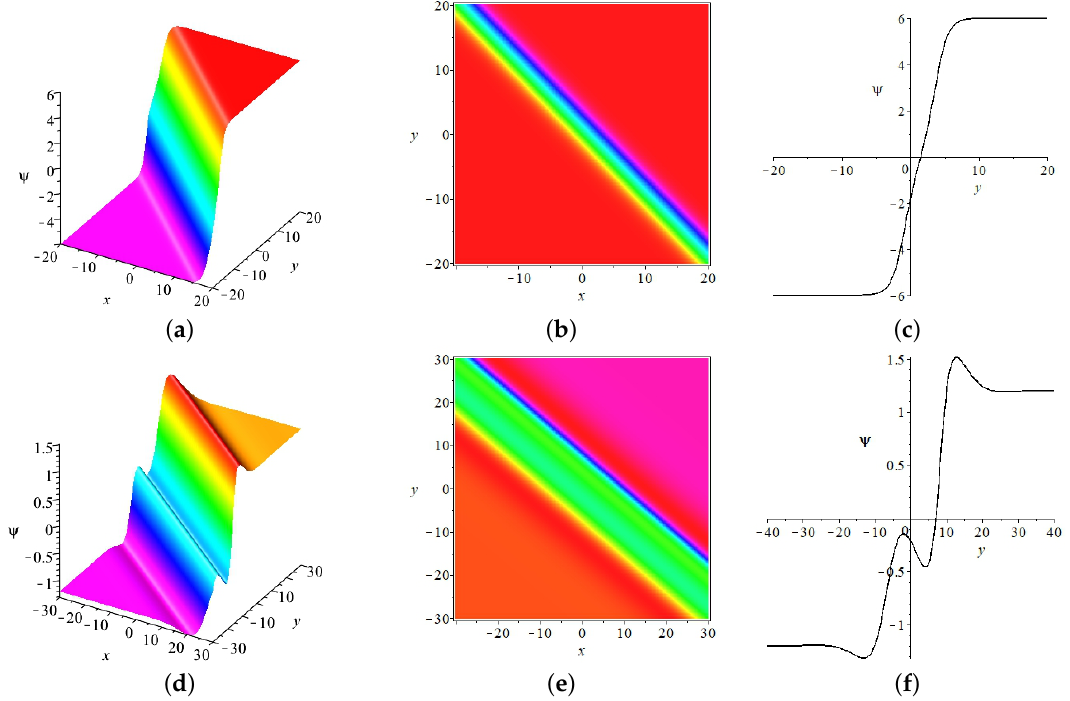
Figure 3. (Color online) The transformation of one-breather with r 2 = r 3 = r 4 = r 6 = r 7 = r 8 = 1, β 1 = 2, γ 1 = 0, κ 1 = 0. In ( a ), a 1 = 1, b 1 = 0.1, c 1 = 1, d 1 = 0, e 1 = 1.2, f 1 = − 2.5. In ( d ), a 1 = 0.2, b 1 = 0.2, c 1 = 1.2, d 1 = 0, e 1 = 0.5, f 1 = − 3.5. These two figures are three-dimensional stereograms when t = 0, z = 0. ( b , e ) are the corresponding contour figure. ( c , f ) show the wave moves along the y axis when x = 0, t = 0, z =